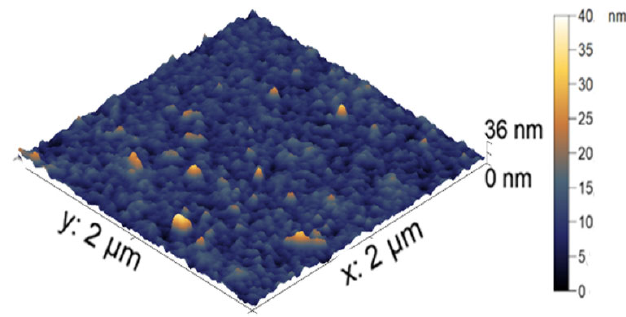
Figure 4. AFM images of the individual nanocomposite particles.